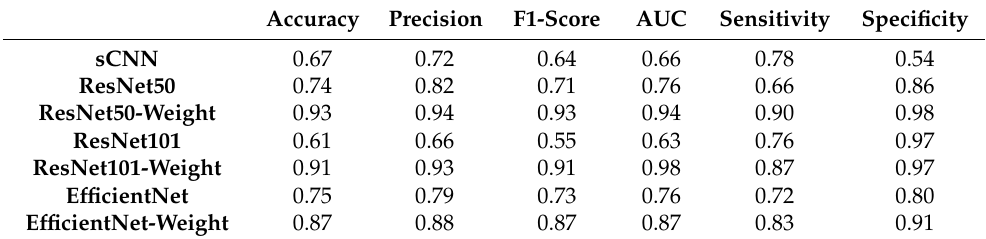
Table 2. Evaluation metrics of each model by using the patient-level splitter.